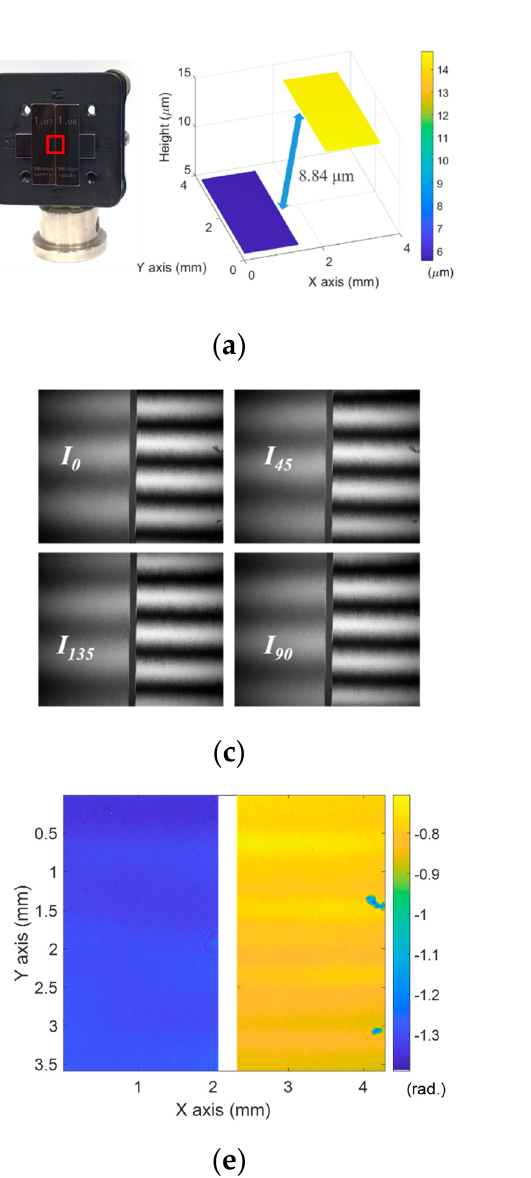
Figure 5. ( a ) Picture of the step height specimen and the measurement result of the step height specimen by low-coherence scanning interferometry (LCSI); ( b ) whole interference fringe of the PCAM; ( c ) four phase-shifted interference fringes; ( d ) wrapped phase map of ϕ fine ; ( e ) ϕ rough obtained by Equation (14) from the visibility; ( f ) calibrated height map.